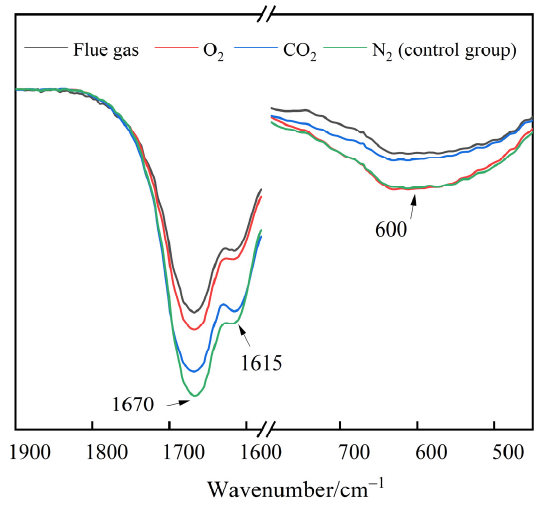
Figure 14. The FTIR spectra of polymer gel after being aged for 180 days.